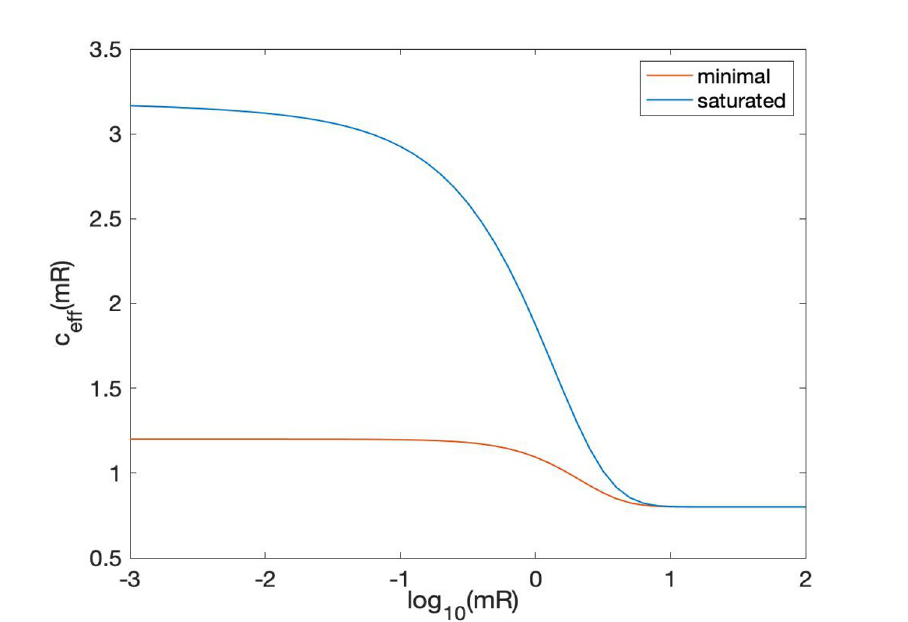
Figure 3 . Minimal and saturated RG flows for su(3) : c ( cally. The IR central charge ( mR → ∞ ) is c IR = 4 / 5 . One clearly sees that both trajectories arrive b to cft from the same direction, namely TT IR